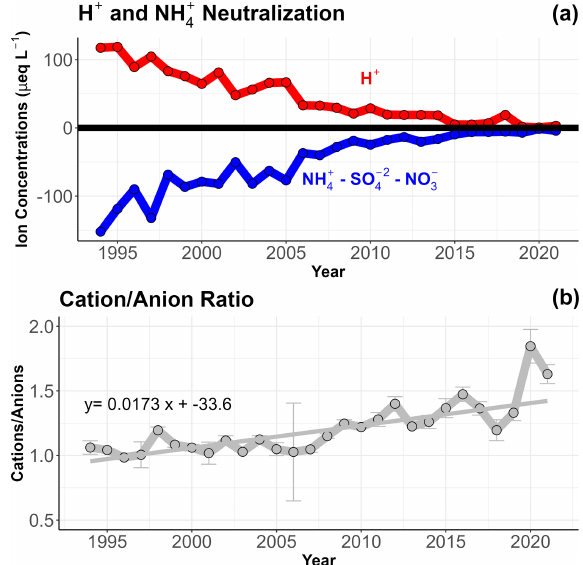
Figure 5. (a) Annual median measured H + concentrations and neu- tralization of SO 2 − and NO − by NH + , and (b) annual median 4 3 4 cation / anion ratios in cloud water collected from the summit of WFM (complete